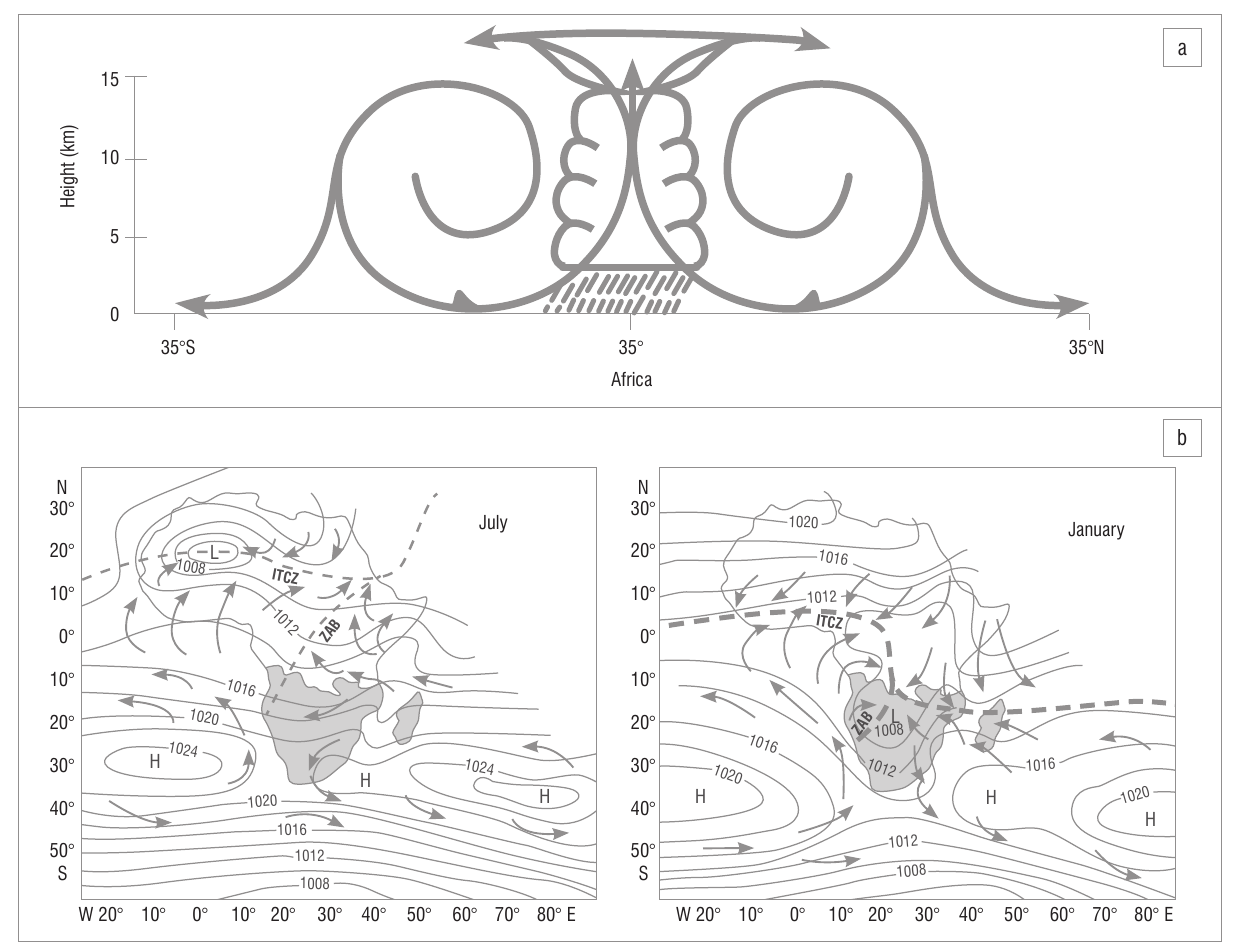
Figure 2: (a) Schematic of the Hadley circulation over Africa in the form of a vertical cross-section from the surface to 15 km extending along the north/ south length of Africa. Ascending air, cloud and rain dominate the equatorial region; descending air, drying and warming dominate the greater part of the continent. (b) The mean surface pressure (mb) and wind (heavy arrows) fields for each season: July, northern hemisphere summer/ southern hemisphere winter, and January, northern hemisphere winter/southern hemisphere summer. The Intertropical Convergence Zone (ITCZ) and the Zaire Air Boundary (ZAB) are shown by heavy dashed lines.